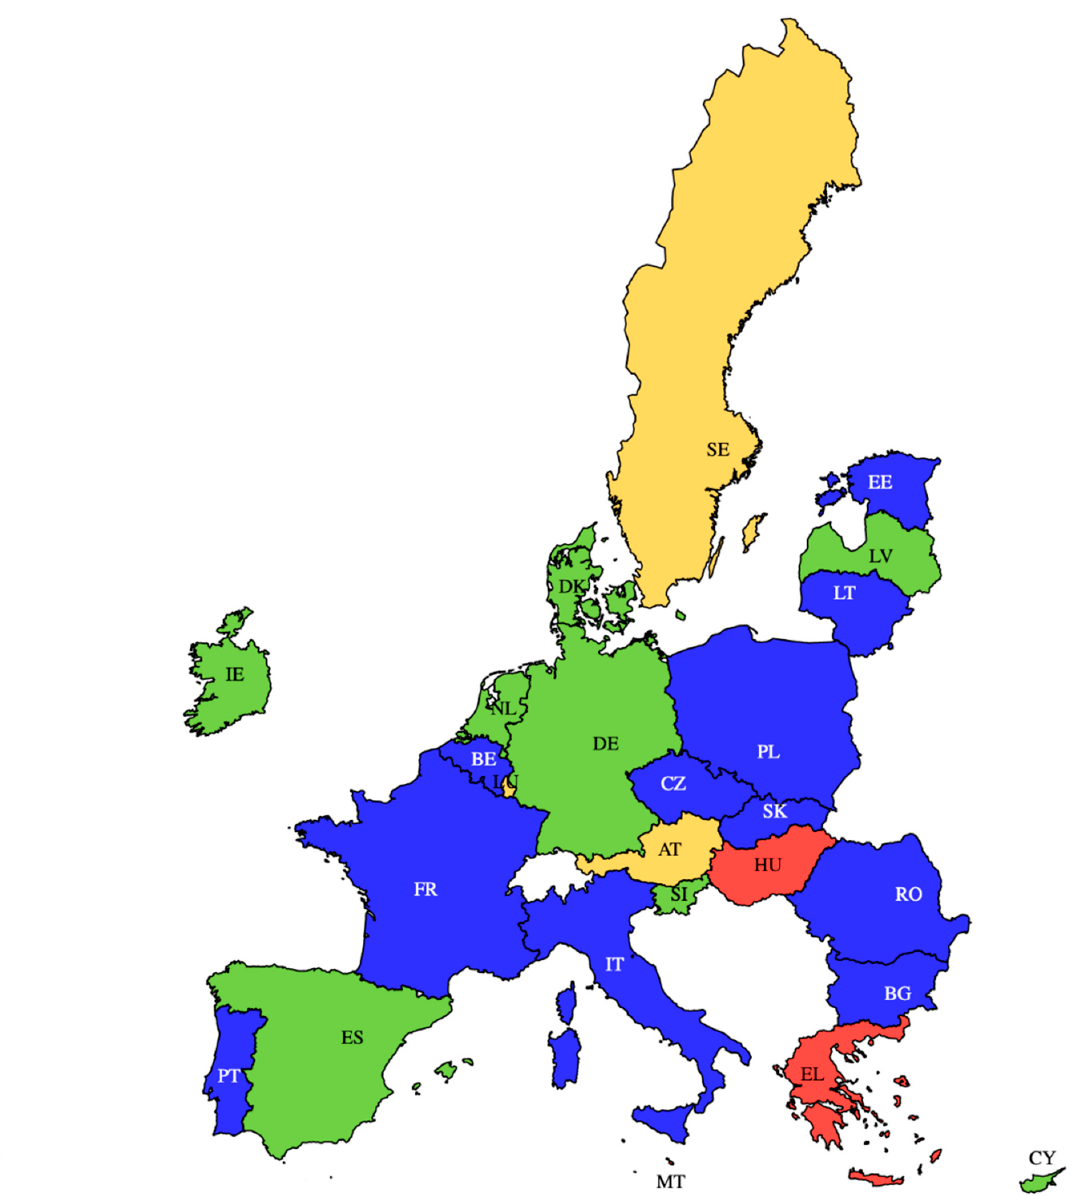
Figure 7. EU countries by typology in 2020. Table 4. Matrix of Pearson correlation coefficients for values of taxonomic measure of development and for the results of ordering of EU countries in years 2010, 2015, and 2020. Years